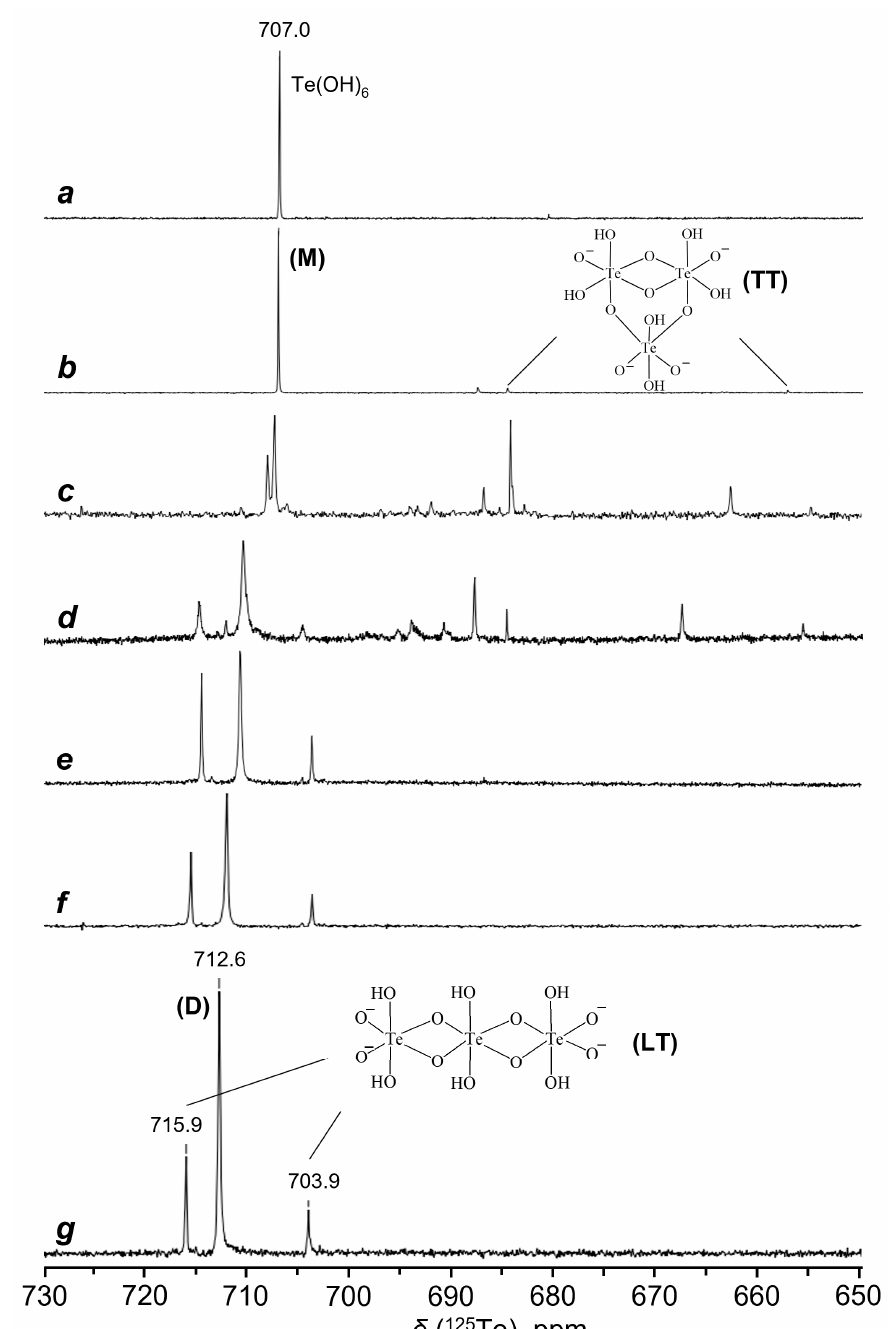
Figure 1. 125 Te NMR spectra of aqueous solutions with different [Te]/[Cs] ratios obtained by neu- tralization of telluric acid with cesium hydroxide: ( a ) solution 1 1 M Te(OH) 6 , [Cs] = 0, pH 2.5, ( b ) solution 2 [Cs]/[Te] = 0.1, pH 5.5, ( c ) solution 3 [Cs]/[Te] = 1, pH 9.2, ( d ) solution 4 [Cs]/[Te] = 1.5, pH 11.5, ( e ) solution 5 [Cs]/[Te] = 2.5, pH 14.3, ( f ) solution 6 [Cs]/[Te] = 3.5, pH 14.8, ( g ) solution 7 [Cs]/[Te] = 4.7, pH 15.2.